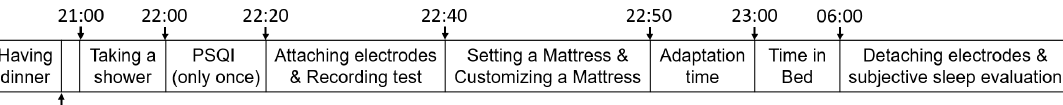
Figure 4. Experimental schedule for a night’s